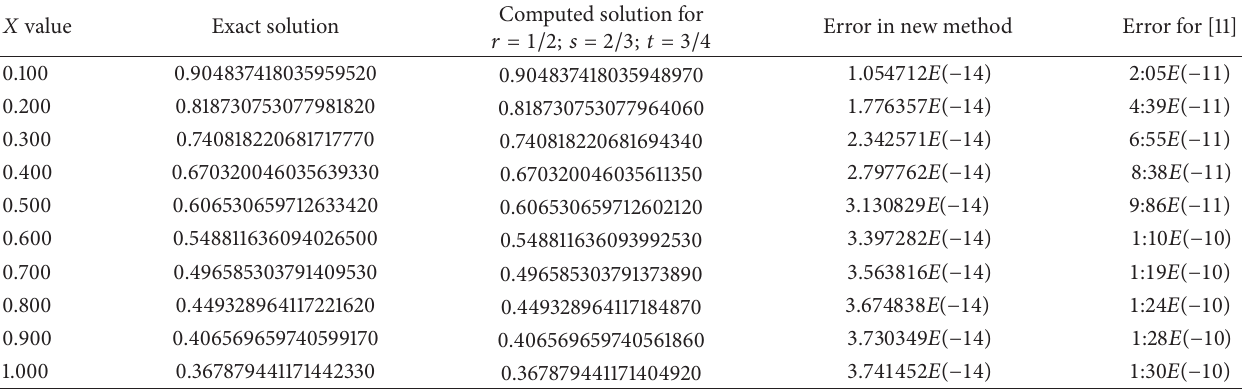
Table 1: Comparison of the proposed method with [11].